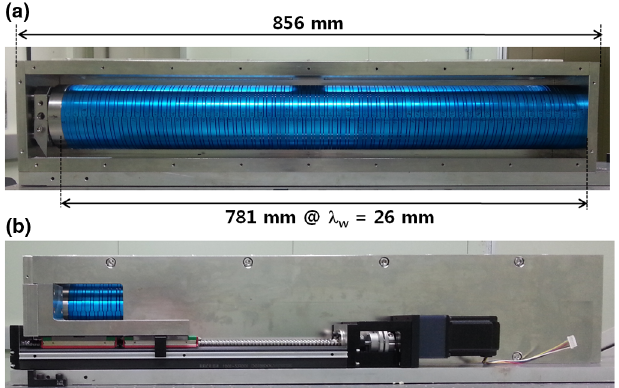
FIG. 4. Photographs of the V-P helical undulator. (a) Right side view of the undulator. Disk modules are azure. (b) Left side view of the undulator. Stepping motor and linear actuator are seen.